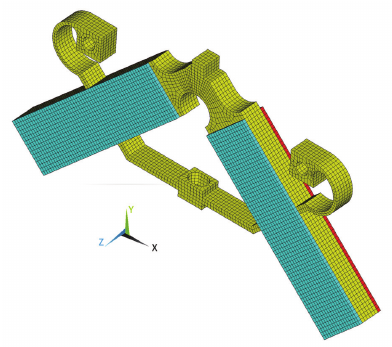
Figure 3. The 3D finite element mesh of the